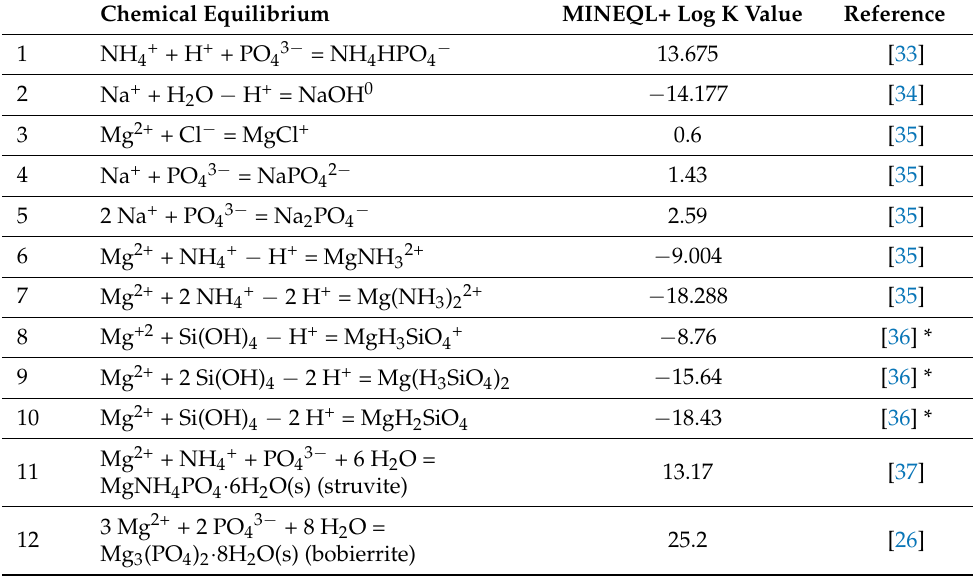
Table A1. Chemical equilibria that were added to the MINEQL+